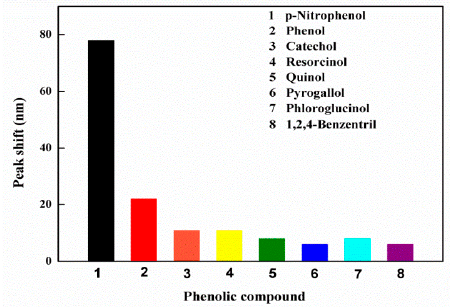
Figure 4. Peak shifts of the IOPPCs in different phenolic compound solutions (50 mM): ( 1 ) p-nitrophenol; ( 2 ) phenol; ( 3 ) catechol; ( 4 ) resorcinol; ( 5 ) quinol; ( 6 ) pyrogallol; ( 7 ) phloroglucinol; ( 8 ) 1,2,4-benzentril.